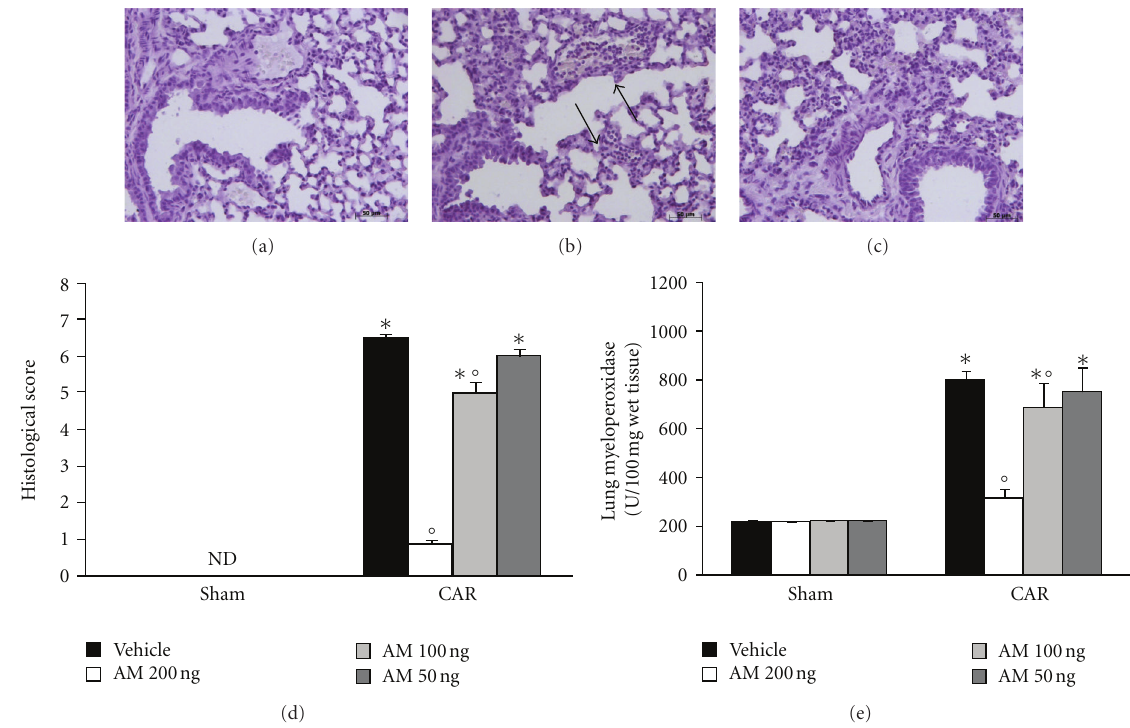
Figure 1: E ff ect of adrenomedullin (AM) on histological alterations and on PMN infiltration in the lung. Lung sections taken from CAR- treated mice treated with vehicle demonstrated edema, tissue injury (b, d), as well as infiltration of the tissue with neutrophils (b). CAR- treated animals treated with AM (c) demonstrated reduced lung injury and neutrophil infiltration in a dose-dependent manner. Section from sham animals showed the normal architecture of the lung tissue (a). The histological score (d) was made by an independent observer. MPO activity, index of PMN infiltration, was significantly elevated at 4h after CAR administration in vehicle-treated mice (e), if compared with sham mice (e). AM significantly reduced MPO activity in the lung in a dose-dependent manner (e). The figure is representative of at least 3 experiments performed on di ff erent experimental days. Data are expressed as mean ± s.e.m. from n = 10 mice for each group. ∗ P < 0 . 01 versus sham group. ◦ P < 0 . 01 versus